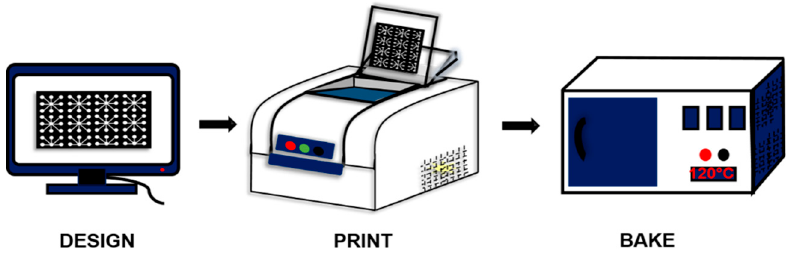
Figure 1. Schematic representation of the fabrication process of paper microfluidic devices. Step1: AutoCAD Design; Step2: Wax Printing on Whatman Paper Grade No.1; and Step 3: Bake at 120 ◦ C